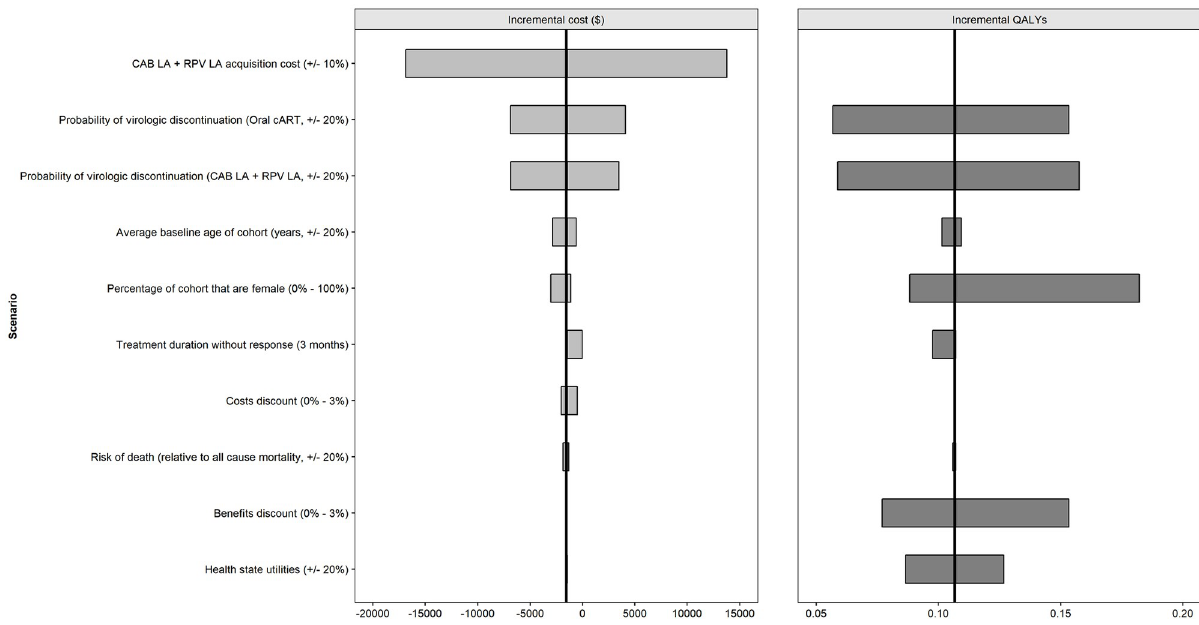
Fig 3. Deterministic (one-way) sensitivity analysis (CAB+RPV LA vs oral cART) CEM parameters. Abbreviations: CAB: cabotegravir; cART: combination antiretroviral therapy; LA: long-acting; QALY: quality adjusted life year; RPV: